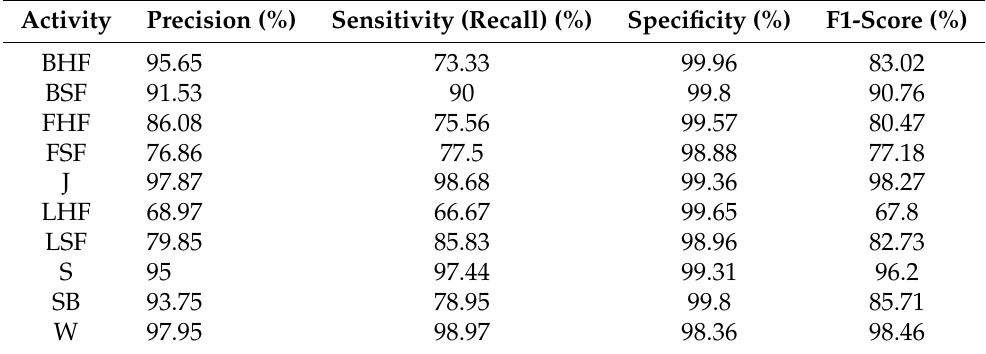
Table 5. Best Results (Obs. Window: 3 s, Sensing Modality: Acc. +